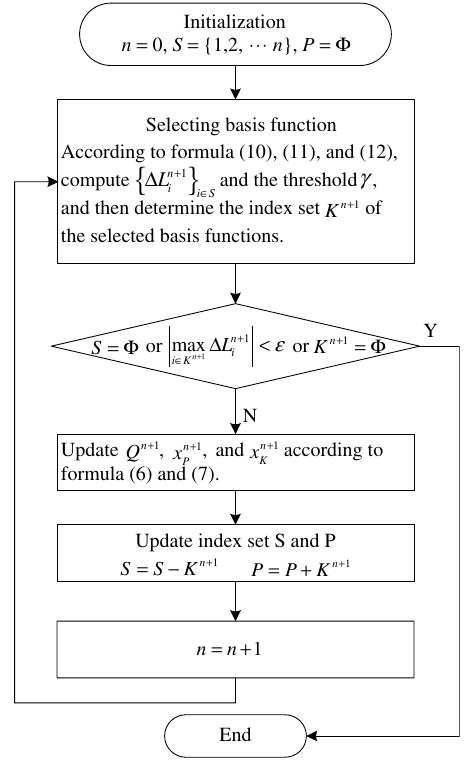
Fig. 1. Flowchart of StF-LASSO algorithm.